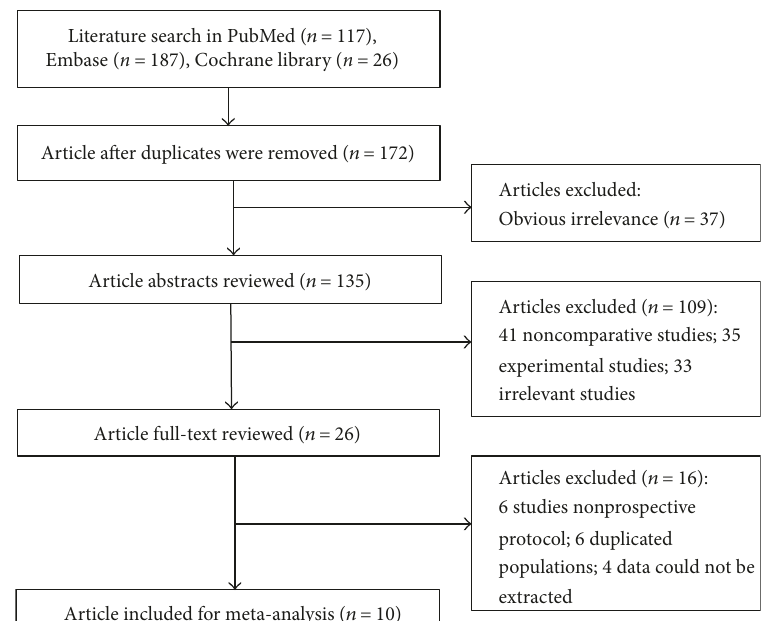
Figure 1: Flow chart of literature search and study